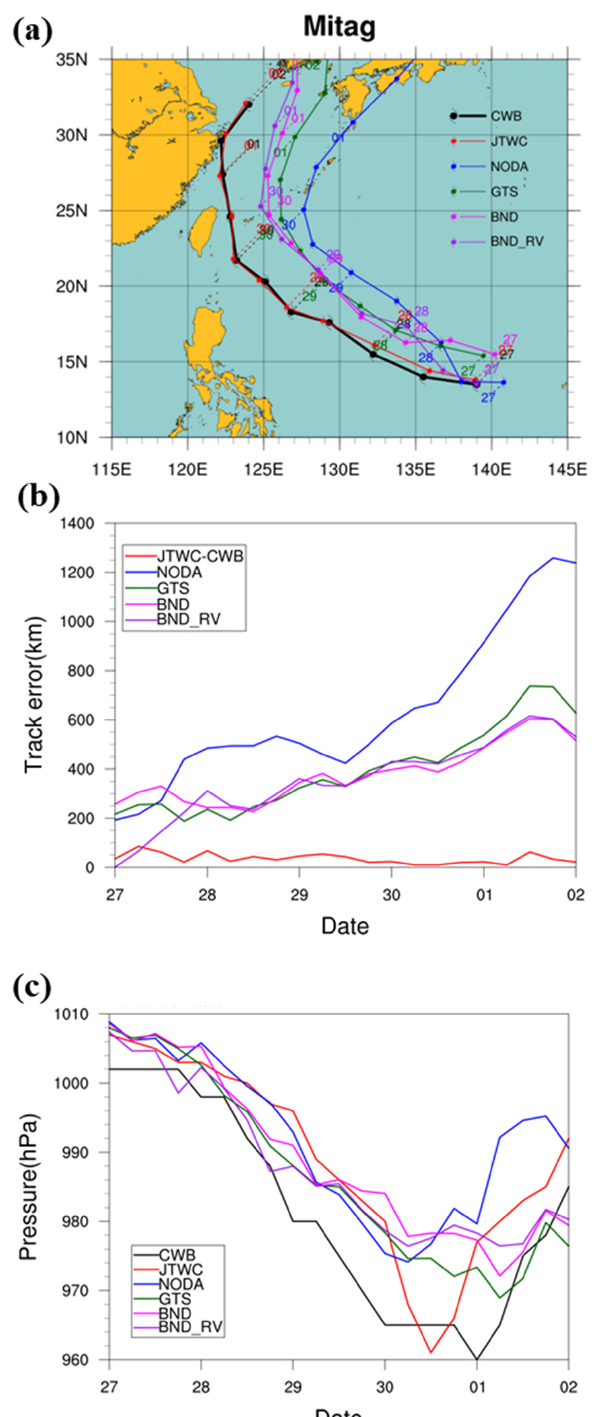
Figure 17. ( a ) The CWB best track (black line), the JTWC best track (red line), and the forecast tracks for NoDA (blue line), GTS (green line), BND (pink line), and BND_RV (purple line) for Typhoon Mitag (2019) starting from 0000 UTC 27 September 2019. ( b ) as in ( a ) but for the track errors, and ( c ) as in ( a ) but for the central sea-level pressure. In ( b ), the red line shows the difference in the JTWC best track from the CWB best track.